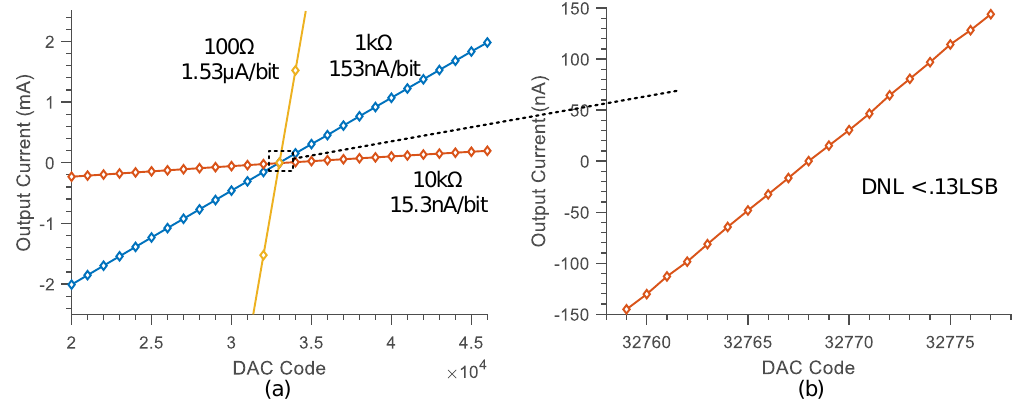
Figure 4. ( a ) Measured transfer function for three gain settings ( R GAIN = 100 Ω , 1 k Ω , and 10 k Ω ). ( b ) Measured linearity around the transition point for high-precision setting (low-gain mode, 10 k Ω ).